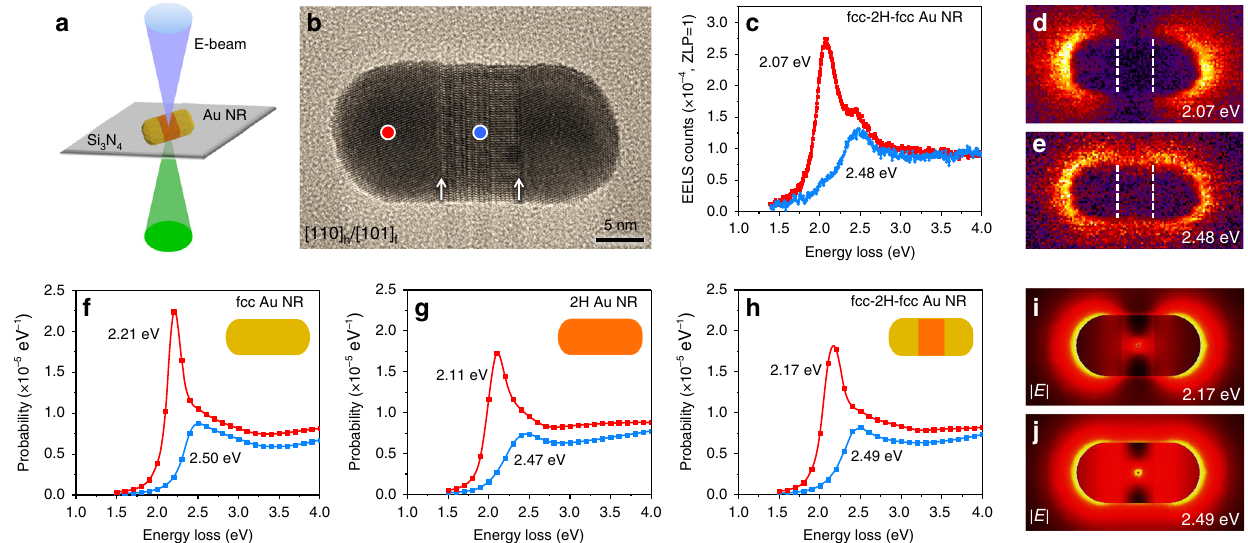
Fig. 2 Monochromated EELS analysis of an individual heterophase fcc-2H-fcc gold nanorod. a Schematic illustration of the monochromated EELS measurement: an electron probe with beam size of ~1 nm 2 is raster-scanned in a rectangular region around the fcc-2H-fcc Au NR, while a monochromated EELS spectrum is measured in each scan pixel. b HRTEM image of an individual fcc-2H-fcc Au NR. The fcc/2H phase boundaries are indicated by white arrows. c Experimental EELS spectra collected in the end (red curve) and middle (blue curve) of fcc-2H-fcc Au NR, as indicated by the red and blue dots in b , respectively. d , e Measured EELS maps of the fcc-2H-fcc Au NR shown in b , displaying the intensity EELS distribution at 2.07 eV ( d ) and 2.48 eV ( e ). The positions of fcc/2H phase boundaries are marked by white dashed lines. f – h Calculated EELS spectra for fcc Au NR ( f ), 2H Au NR ( g ) and fcc-2H-fcc Au NR ( h ) at two E-beam excitation locations: in the end (red curve) and middle (blue curve). Insets: the corresponding theoretical models of single fcc Au NR ( f ), 2H Au NR ( g ) and fcc-2H-fcc Au NR ( h ). i , j Simulated total fi eld distributions at two resonant energies of 2.17 eV ( i ) and 2.49 eV ( j ) excited by an E-beam in the middle of an fcc-2H-fcc Au